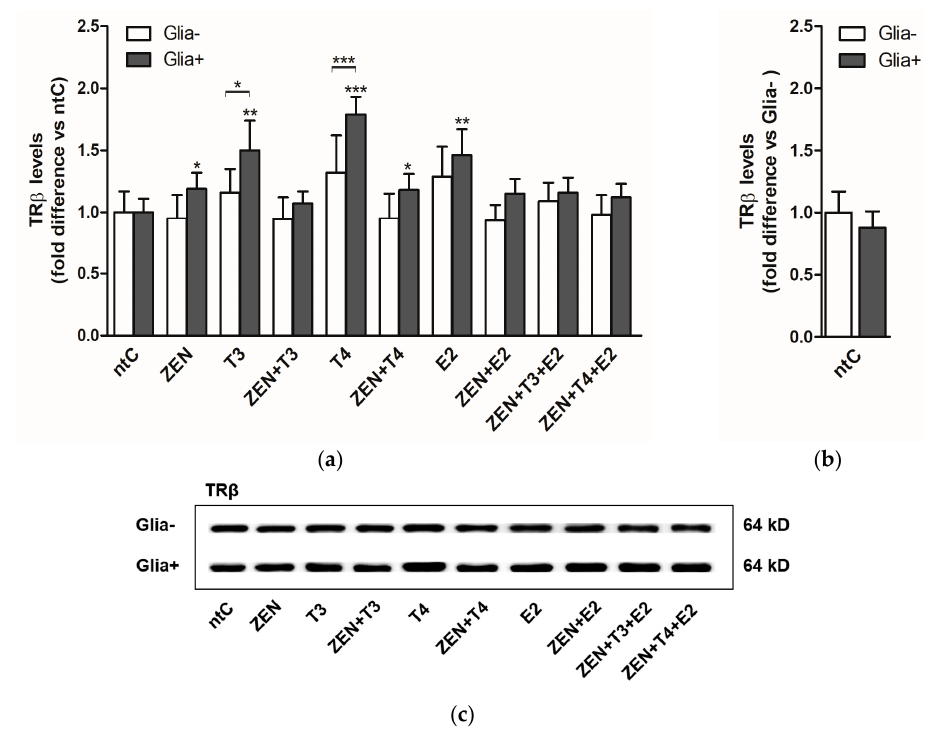
Figure 4. TR β protein expression levels in cerebellar granule cells in the absence, Glia − , or presence of glial cells, Glia+; treated with zearalenone (ZEN), and/or triiodo-thyronine (T3), thyroxine (T4) and 17 β -estradiol (E2) for 18 h, examined by Western blotting. ( a ) Shown P-values were calculated: compared to ntC (above and next to the bars) and Glia+ compared to Glia − (*) p < 0.05, (**) p < 0.01, (***) p < 0.001 (above braces) in each treatment group. ( b ) Expression of TR β protein in non-treated controls normalized to Glia − ( p -value not shown). All data represents the mean ± SD of at least three independent experiments ( n = 6 per treatment). ( c ) Representative Western blot images.